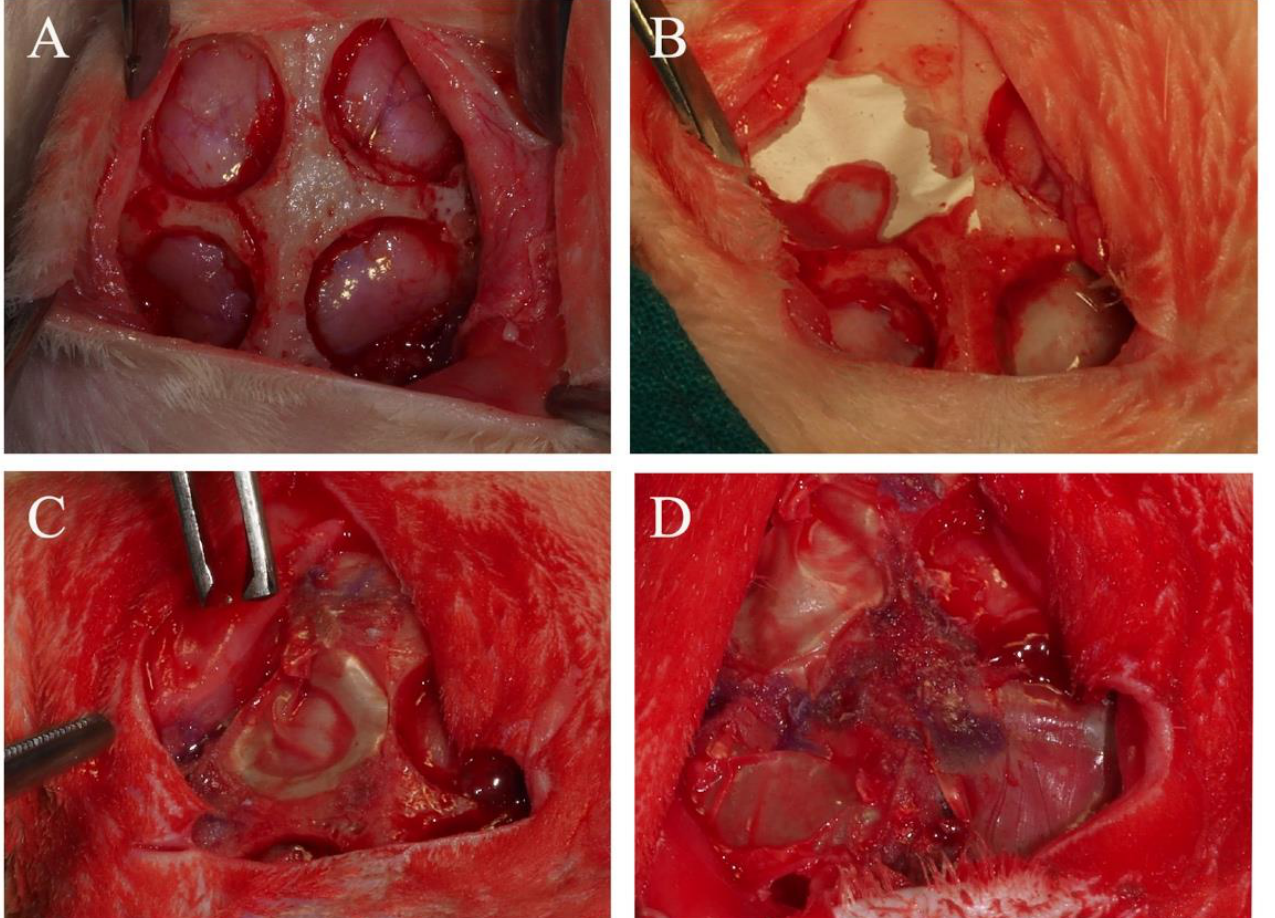
Figure 1. ( A ) Four critical defects were practiced at the parietal bone on each side of the skull midline, permitting the observation of the dura mater . ( B ) A membrane was placed on a calvarial defect. ( C ) Two membranes covered two of the four defects. ( D ) Three membranes were placed; the sham group may also be